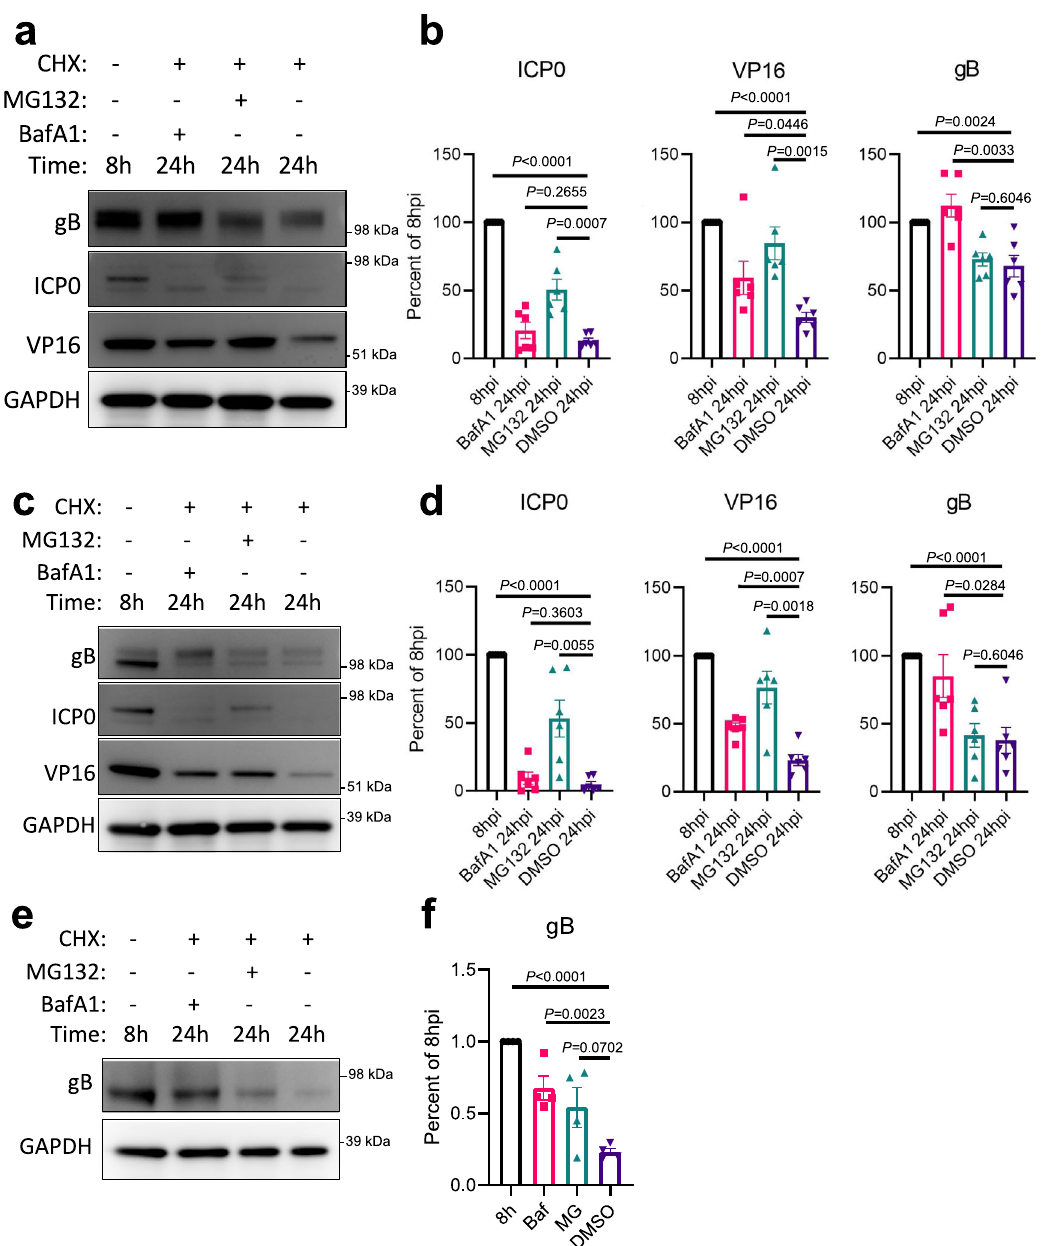
for 8 h before CHX addition to block protein synthesis. In combination with CHX, either the autophagy inhibitor BafA1, the proteosome inhibitor MG132, or DMSO were added to cells. Cells were sampled at 8 h, and 24 h after infection. a Shown for HeLa cells are immunoblots against the HSV-1 proteins gB, ICP0, VP16, and the internal reference GAPDH, b with band quanti fi cation relative to GAPDH ( n = 6 replicates). c Shown for HCE cells are immunoblots against the HSV-1 proteins gB, ICP0, VP16, and the internal reference GAPDH, d with band quanti fi cation relative to GAPDH ( n = 6 replicates). Similarly, LUHMES cells were infected at 2.5 MOI with HSV-1 17-strain for 8 h before CHX addition to block protein synthesis. In combination with CHX, either BafA1, MG132 or DMSO were added to cells. Cells were sampled at 8 h, and 24 h after infection. e Shown for LUHMES cells are immunoblots against the HSV-1 protein gB and the internal reference GAPDH, f with band quanti fi cation relative to GAPDH ( n = 4 replicates). Data are presented as mean values ± SEM ( b , d , f ). Two-tailed Student ’ s t test was performed for statistical analysis ( α = 0.05). ∗ p < 0.05; ∗∗ p < 0.01; ∗∗∗ p < 0.001, ∗∗∗∗ p < 0.0001, ns not signi fi cant. Source data are provided as a Source Data fi